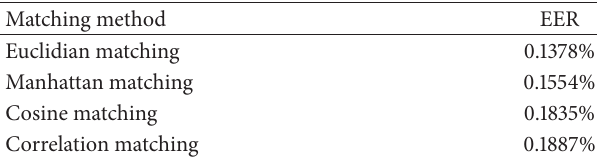
Table 5: Experimental result proposed system. Table 6: The EER comparisons with other